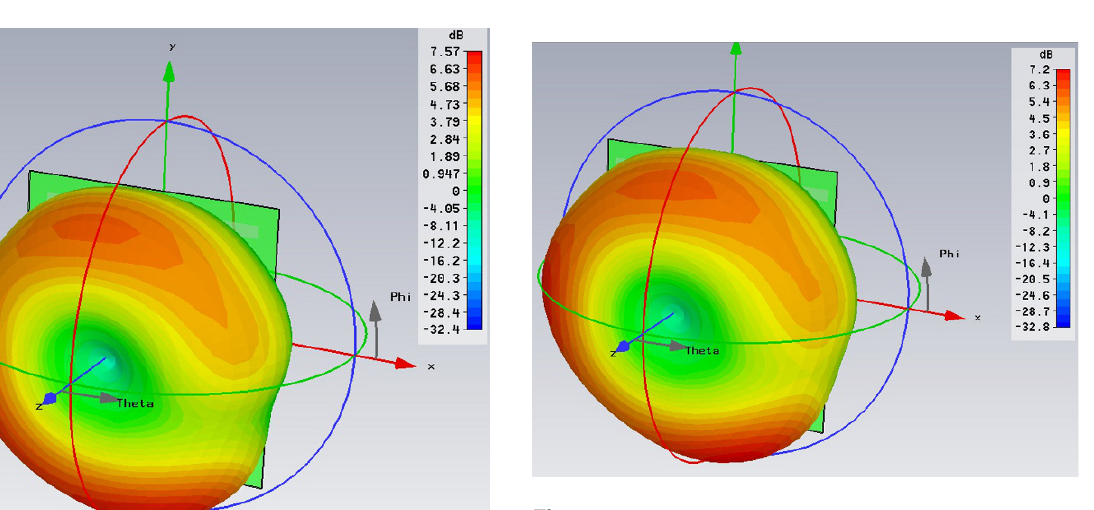
Figure 14. Radiation pattern for 80°. Figure 12 and 13 with almost no change in the back lobe